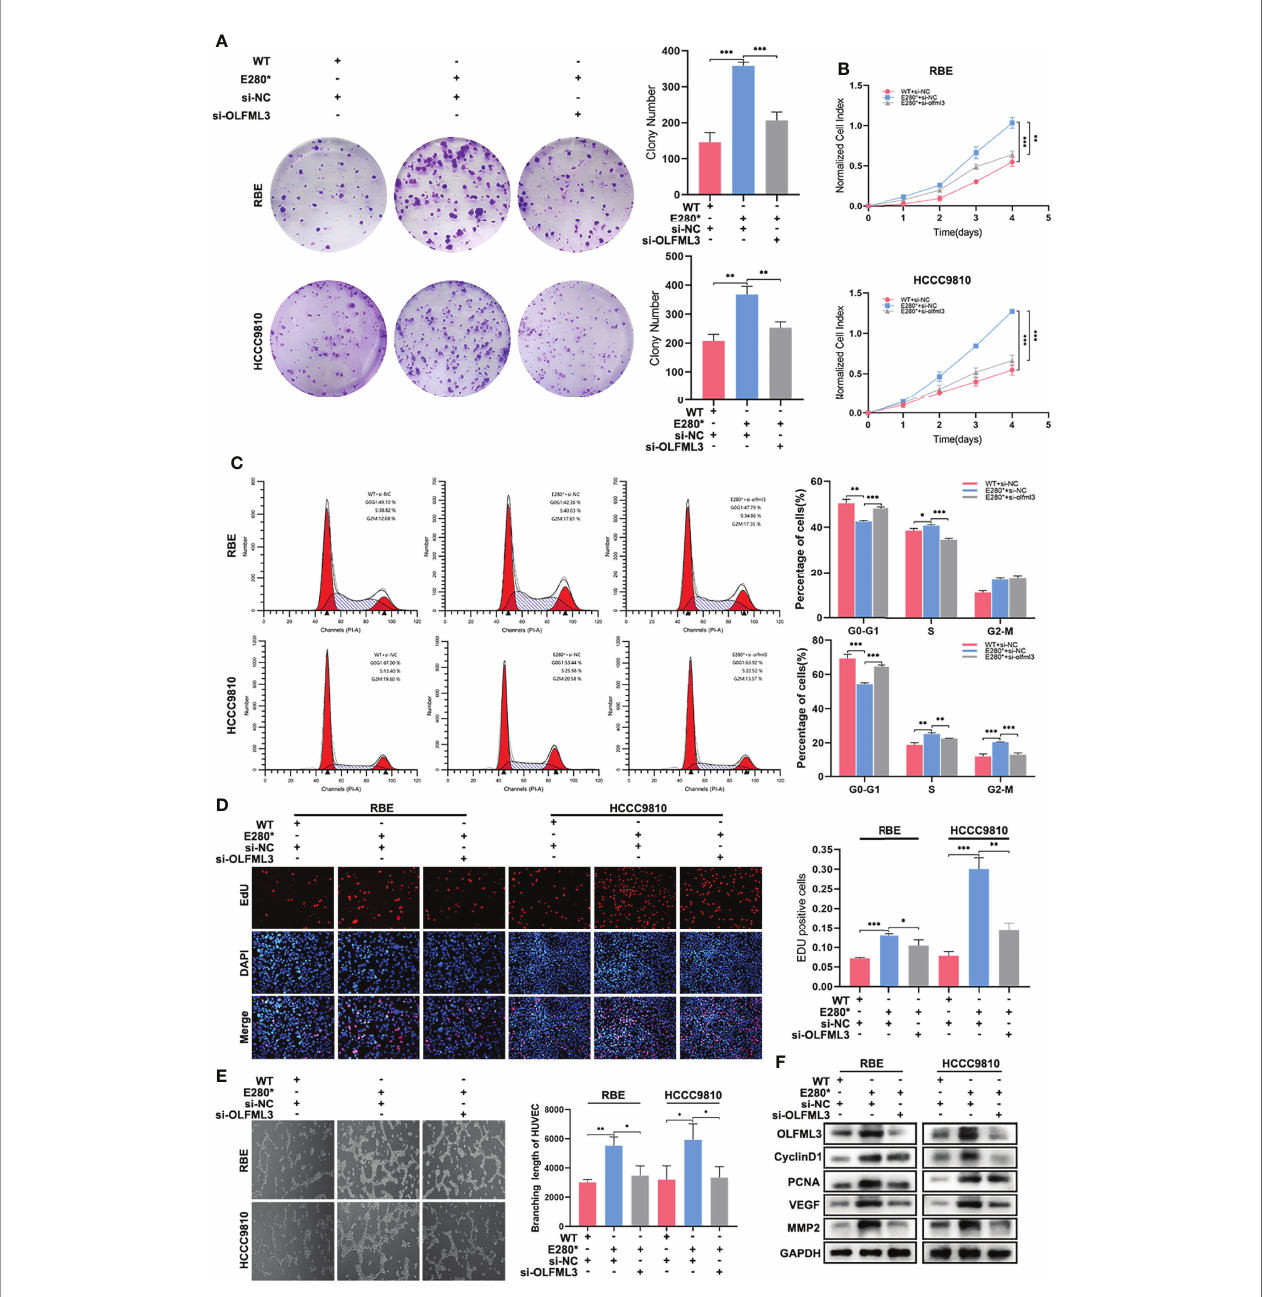
FIGURE 7 | OLFML3 was essential for ROBO1 E280 *-induced proliferation and angiogenesis in cholangiocarcinoma. (A) The knockdown of OLFML3 impaired the clone formation ability of ROBO1 E280 * cells. (B) The knockdown of OLFML3 reduced the proliferation rate of ROBO1 E280 * cells. (C) Flow cytometry analysis of the cell cycle of ROBO1 WT cells transfected with si-NC, ROBO1 E280 * cells transfected with si-NC, and of ROBO1 E280 * cells transfected with si-OLFML3. (D) The ascending proportion of EdU- positive cells in the ROBO1 E280 * group was rescued by the knockdown of OLFML3. (E) The knockdown of OLFML3 decreased the branching length of human umbilical vein endothelial cell line in the ROBO1 E280 * cells. (F) Western blotting analysis of proliferative markers (cyclin D1 and PCNA) and angiogenic markers (VEGF and MMP2). * P < 0.05, ** P < 0.01, *** P <